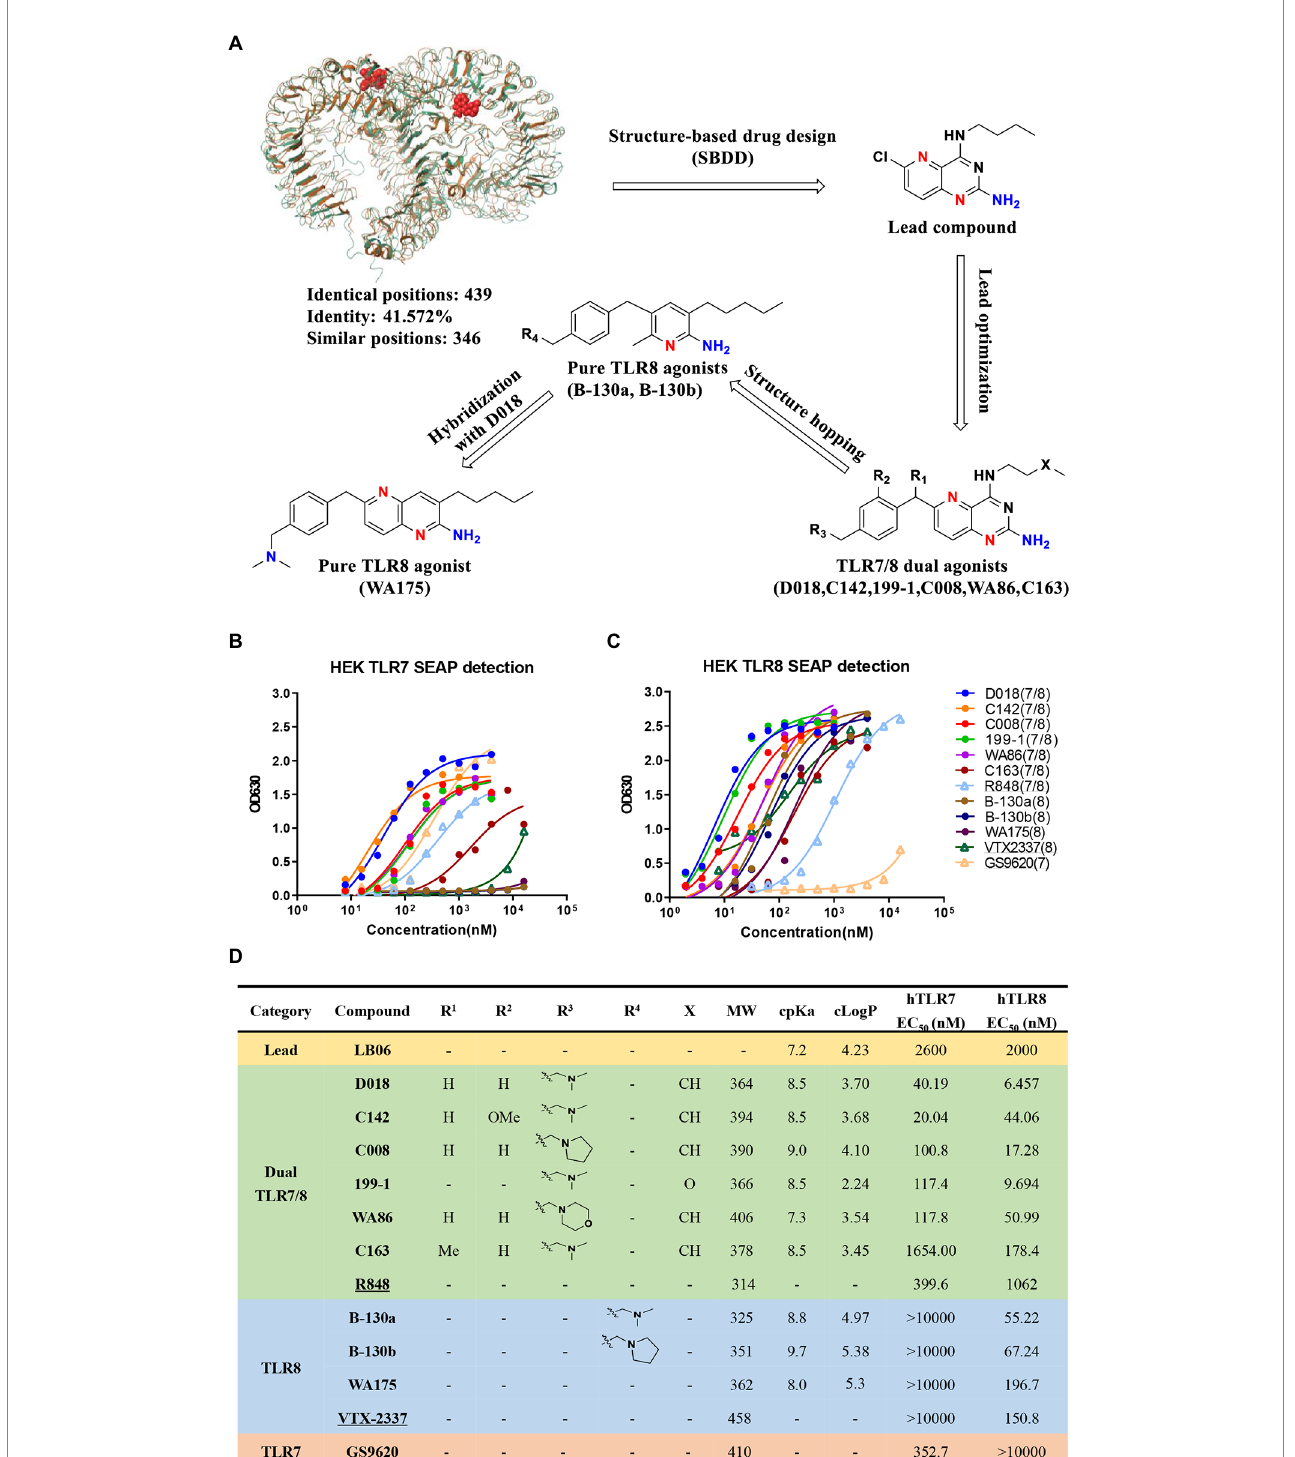
FIGURE 1 Design, synthesis, and evaluation of novel TLR7/8 agonists through HEK-Blue cell lines expressing either hTLR7 or hTLR8 receptor. (A) The design flowchart and chemical structures of novel TLR7/8 agonists with single TLR8 or dual TLR7/8 agonistic activity. Superimposition of MmTLR7-R848 cocrystal (5GMH, brown) and hTLR8-R848 cocrystal (3W3N, bottle green) was performed by Maestro software (v9.1). (B,C) Activity evaluation of TLR7/8 agonists through HEK-Blue cell lines expressing either hTLR7 (B) or hTLR8 (C) receptor, measured by the secreted embryonic alkaline phosphatase (SEAP) in the culture supernatant. Commercially available GS9620 (TLR7 agonist), VTX-2337 (TLR8 agonist), and R848 (TLR7/8 dual agonist) labeled unfilled triangle are reference compounds. (D) TLR7/8 agonists were divided into 4 categories, exhibiting the molecular structure (R1,R2,R3,R4,X refer to the functional group in A ), molecular weight (MW), cpKa, cLogP, as well as EC50 values for hTLR7 and hTLR8. Commercially available GS9620 (TLR7 agonist), VTX-2337 (TLR8 agonist), and R848 (TLR7/8 dual agonist) labeled as underlined are reference